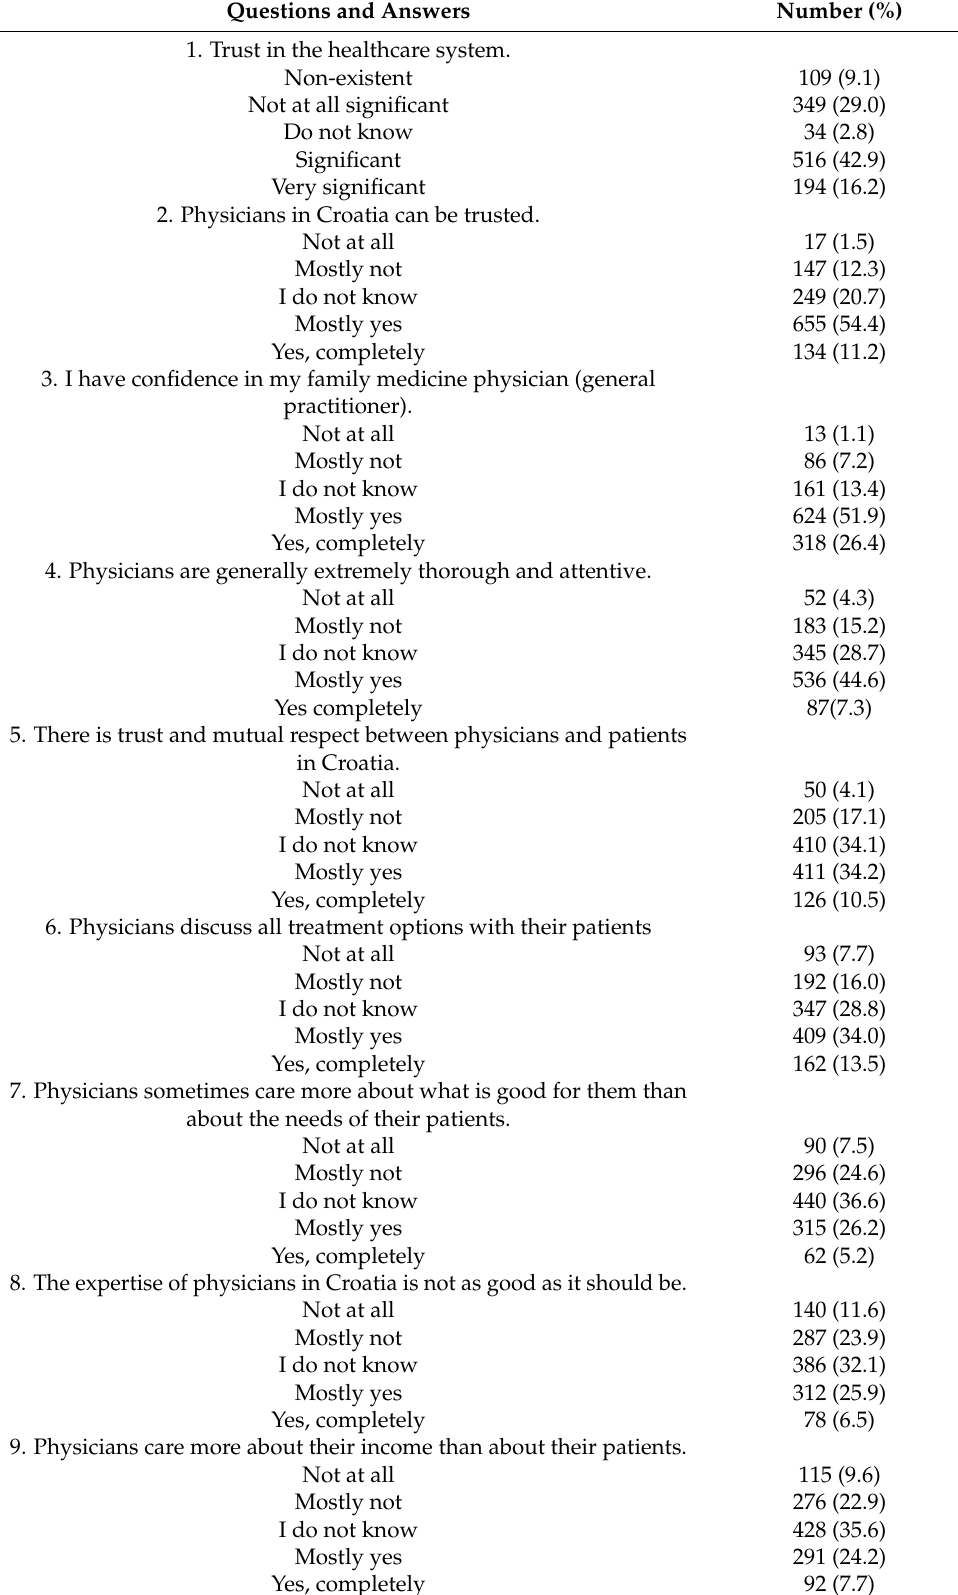
Table 4. Distribution of respondents ’